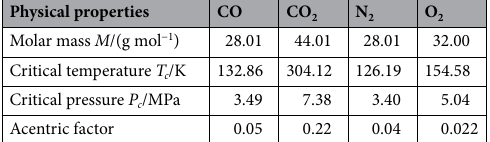
Table 1. Physical properties of the gases.